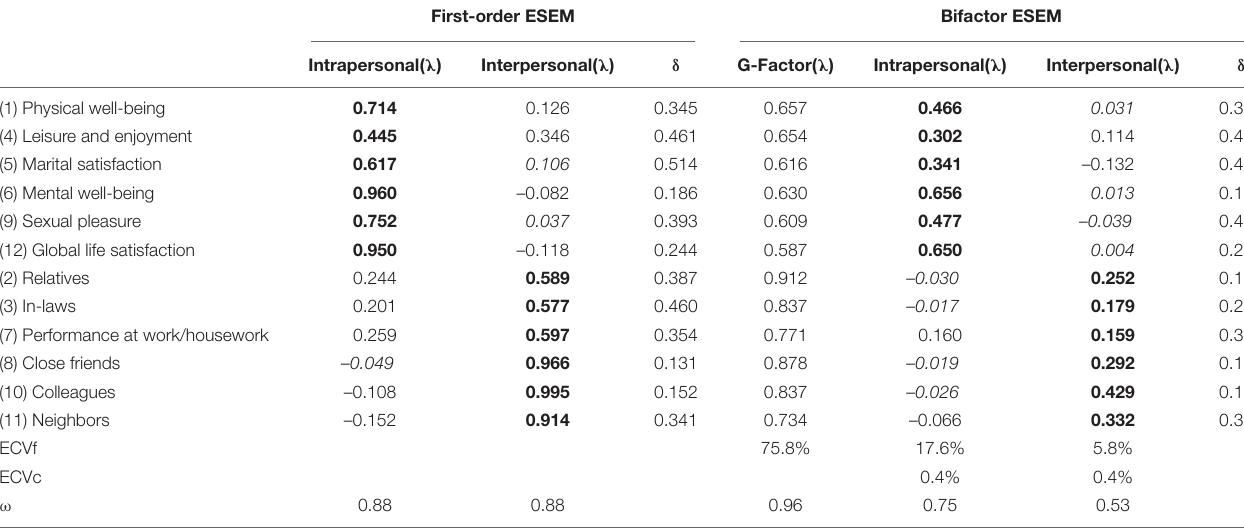
TABLE 2 | Standardized factor loadings and item uniquenesses for the first-order and bifactor ESEM solutions ( n =